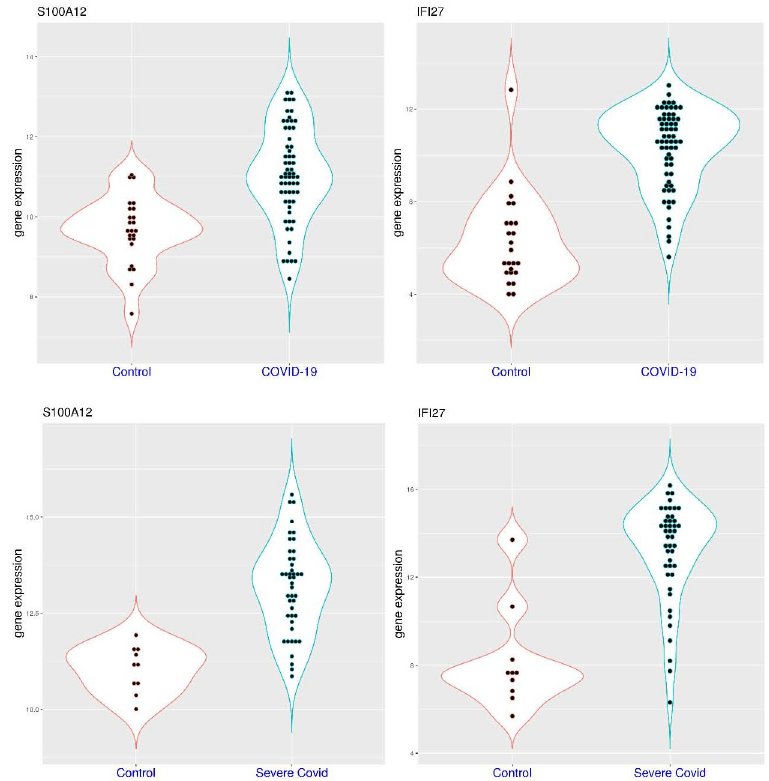
Fig 1. Activation of S100A12 and IFI27 in a significant portion of hospitalized COVID-19 patients compared to healthy controls (whole blood). A) upper panel (dataset GSE152641), comparison of S100A12 and IFI27 expression in healthy controls and hospitalized COVID-19 patients. B) lower panel (dataset GSE171110), comparison of S100A12 and IFI27 expression in healthy controls and severe COVID-19 patients.